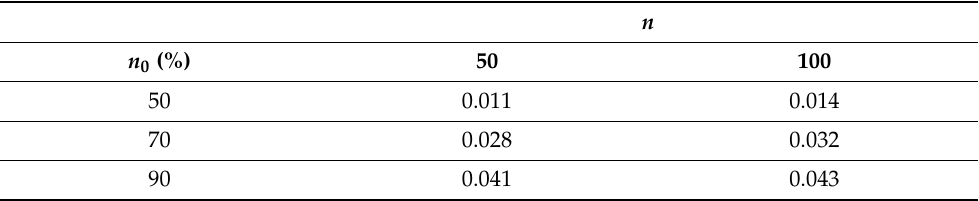
Table 1. Proportion of false alarms (Type I error) for various scenarios in which independence between curves has been assumed, defined also by different values of n , n 0 , and θ = 0.78.